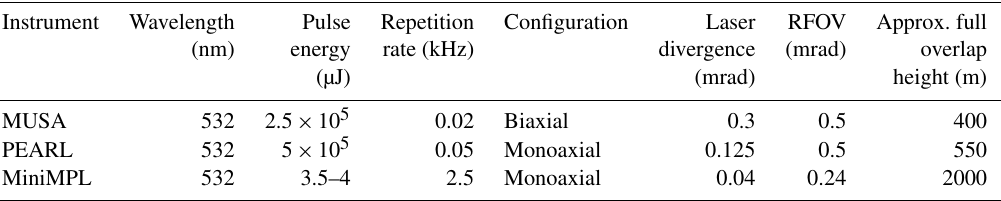
Table 1. Specifications of MUSA, PEARL and MiniMPL at 532nm. All the lidars are operated in the zenith-pointing mode. RFOV indicates the half-angle rectangular field of view of the instruments.